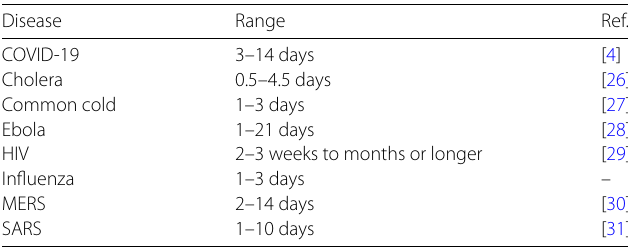
Table 1 Incubation period of several common infectious diseases